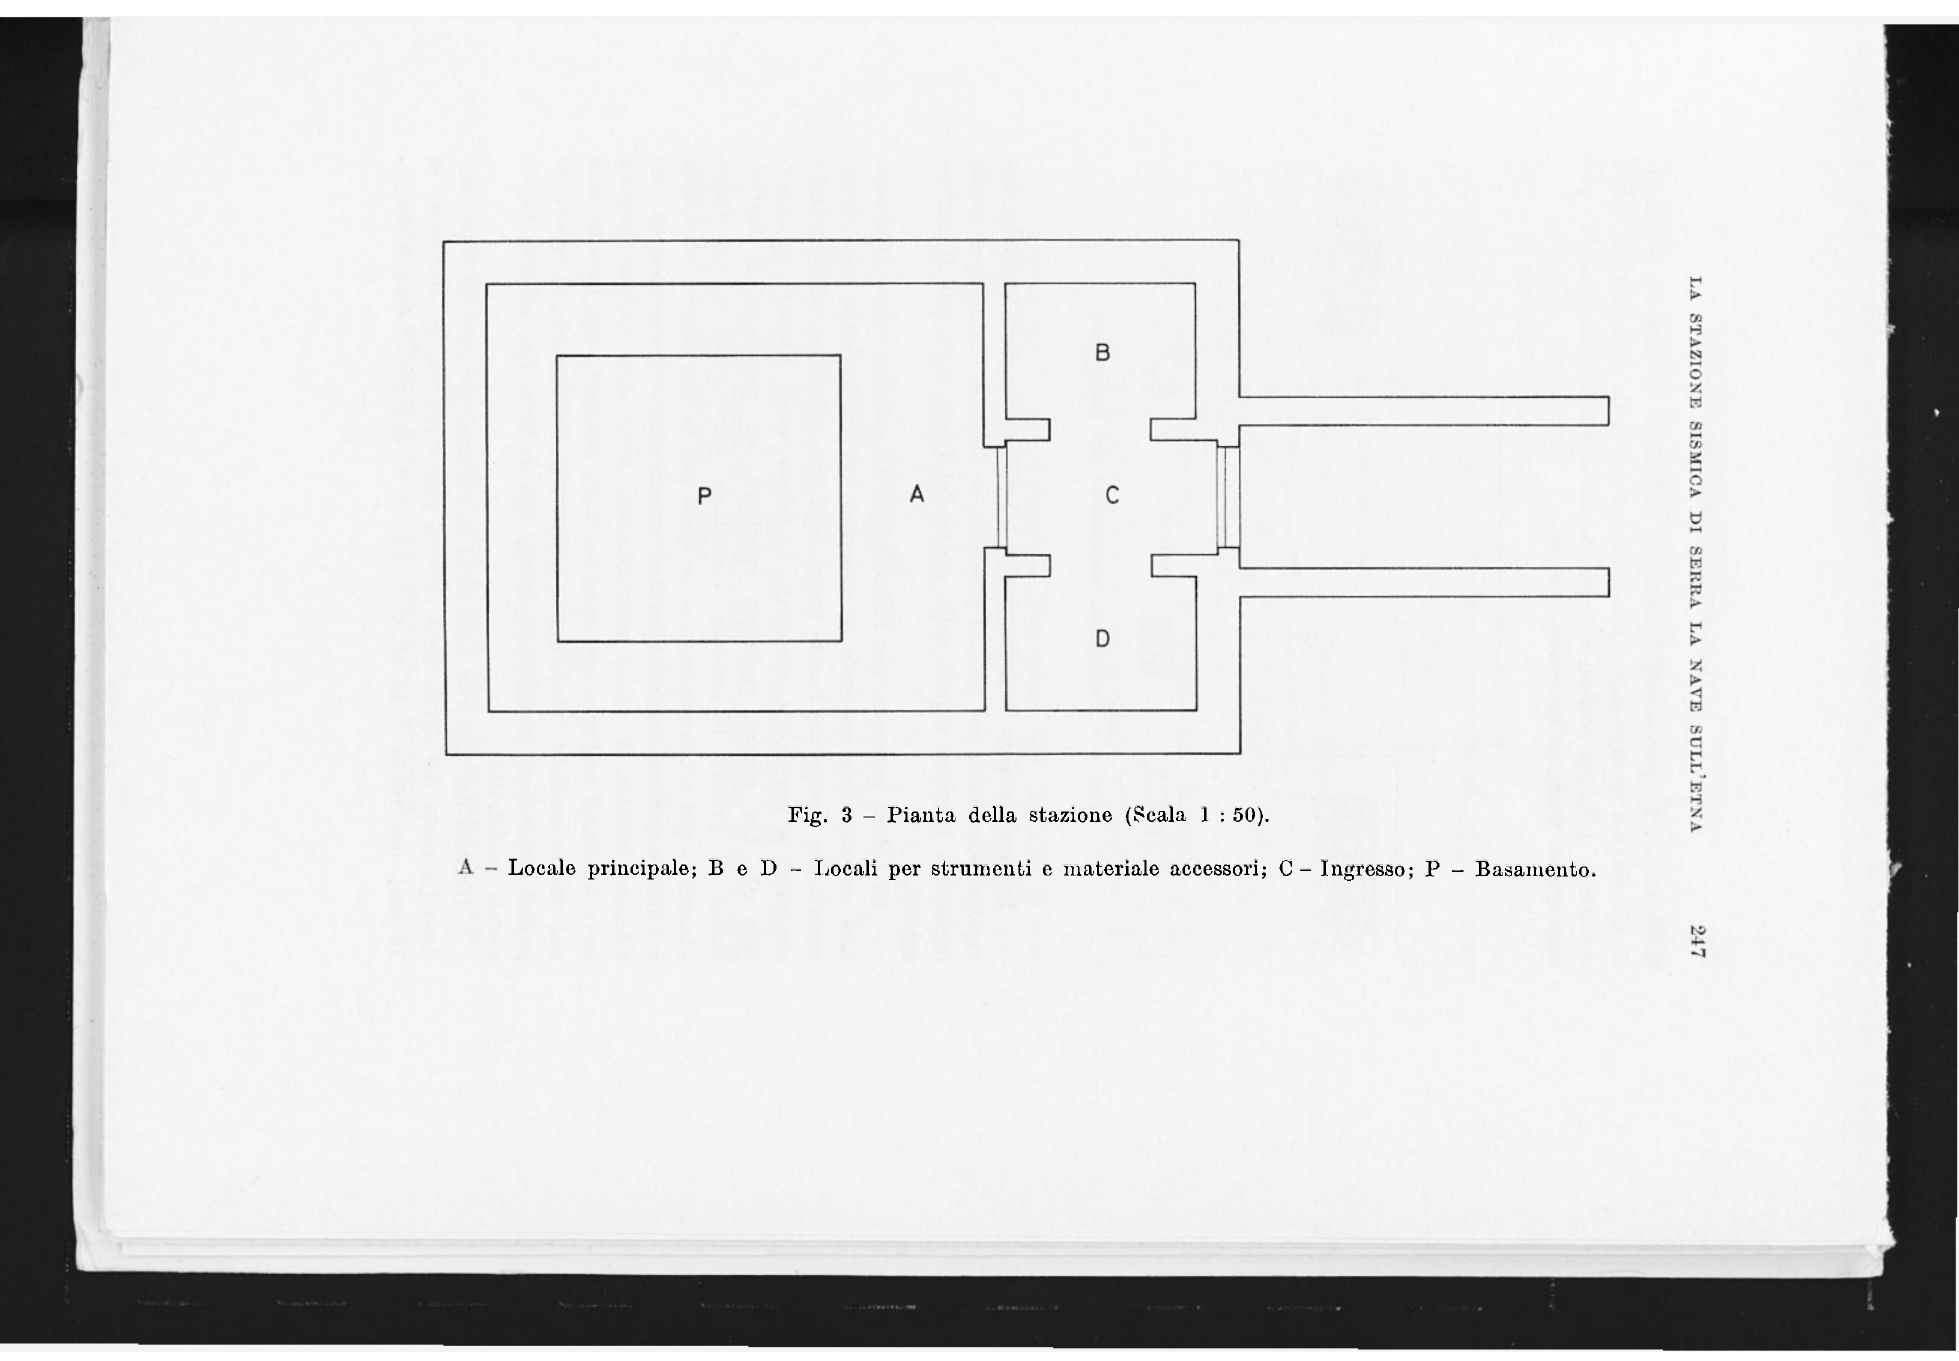
Fig. 3 - Pianta della stazione (Scala 1 :